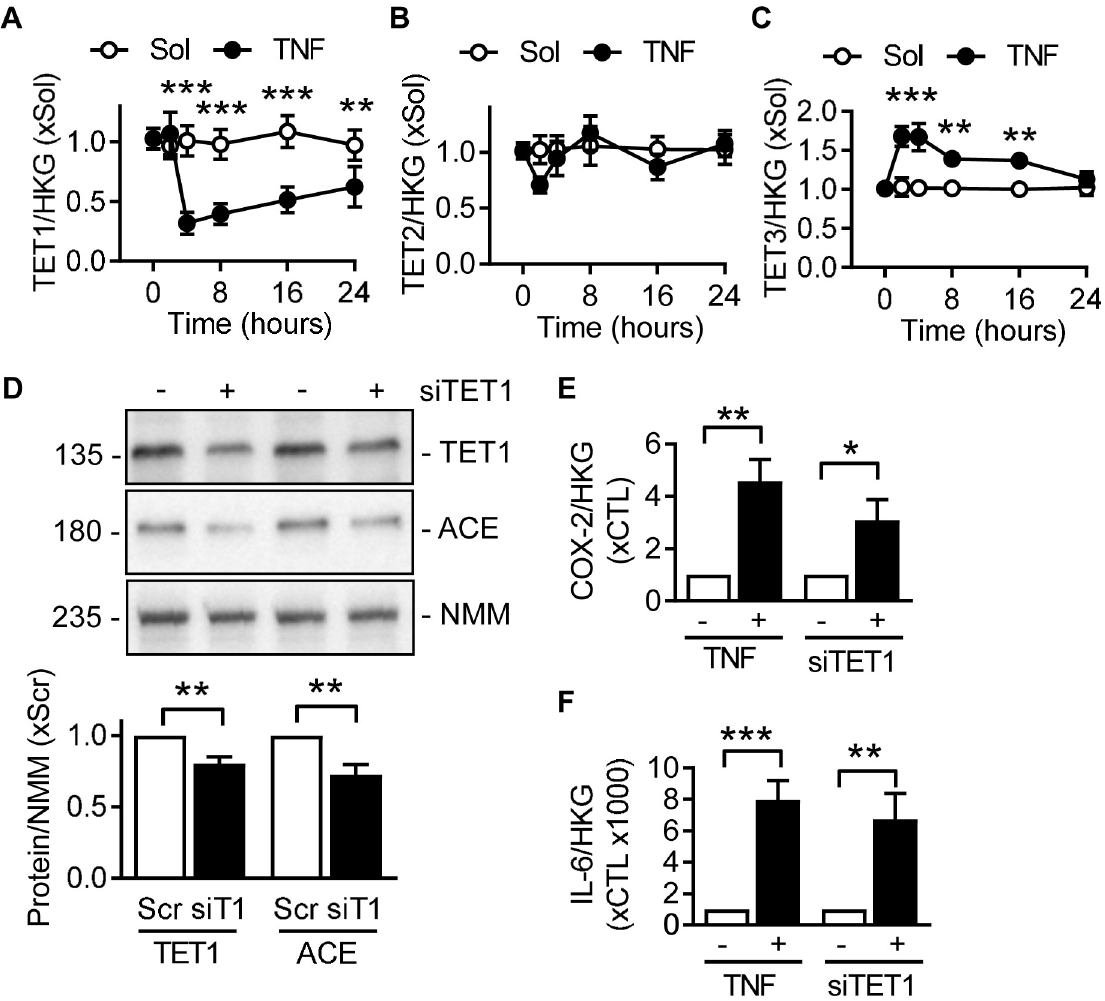
Fig 5. TET1-dependency of TNF α -mediated ACE downregulation in human endothelial cells. (A-C) Time course of the effects of TNF α (10 ng/mL) on TET1 (A), TET2 (B) and TET3 (C) mRNA levels in human endothelial cells relative to a triplet of housekeeping genes (HKG); all n = 5–6 independent cell batches (two-way ANOVA/Bonferroni). (D) RNA interference experiments (50 μ mol/L) against TET1 (siT1). A scrambled (Scr) oligonucleotide was used as control. Protein expression levels of TET1 (left panel) and ACE (right panel) versus non-muscle myosin heavy chain (NMM); n = 4-5 independent cell batches (Student’s t -test). (E-F) Effect of TNF α (10 ng/mL, 24 hours, left panel) and siRNA against TET1 (50 μ mol/L, right panel) on the expression of cyclooxygenase-2 (COX-2) mRNA (E) and interleukin-6 (IL- 6) mRNA (F) versus HKG; n = 4–5 independent cell batches (Student’s t -test). � P < 0.05, �� P < 0.01, ��� P <